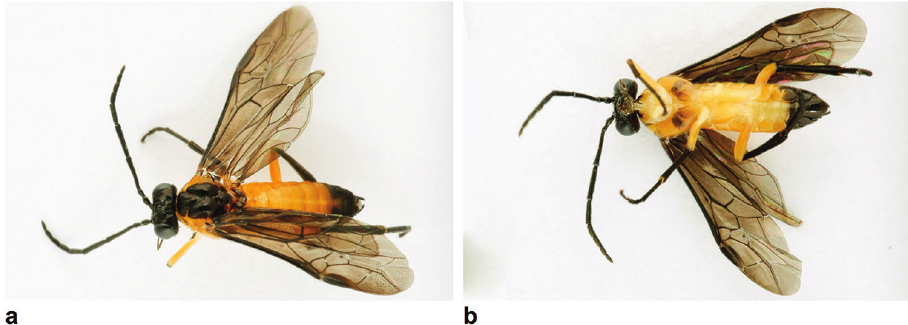
Figure 15. Waldheimia sp., male (P4226.C), body length 8.0 mm. a Dorsal view b ventral Subfamily Selandriinae Adiaclema sp. Fig. 16 Material. Estación científica Yasuní, near río Tiputini, 00°40'S, 076°24'W, 230m, 14.11.2016, on leaf of Heliconia sp., P4217.B (1 ♂ ), 16.11.2016, on leaf of Heliconia sp., P4223.A (1 ♂ ), leg. J.-L. Boevé.